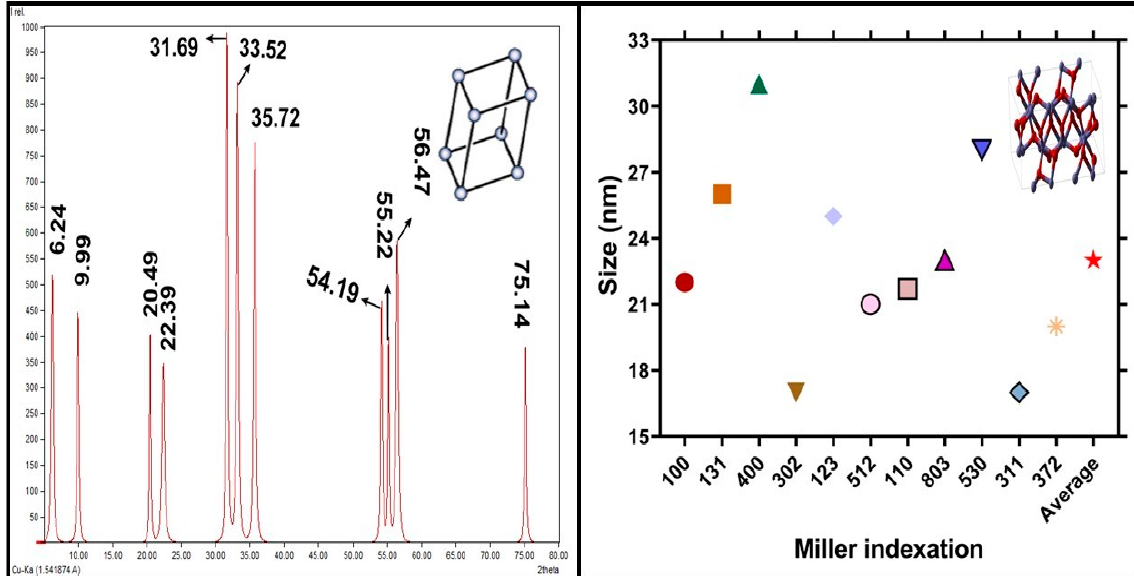
Figure 4. X-ray diffractive analysis of IONPs NPs. Size calculation via Scherer equation.